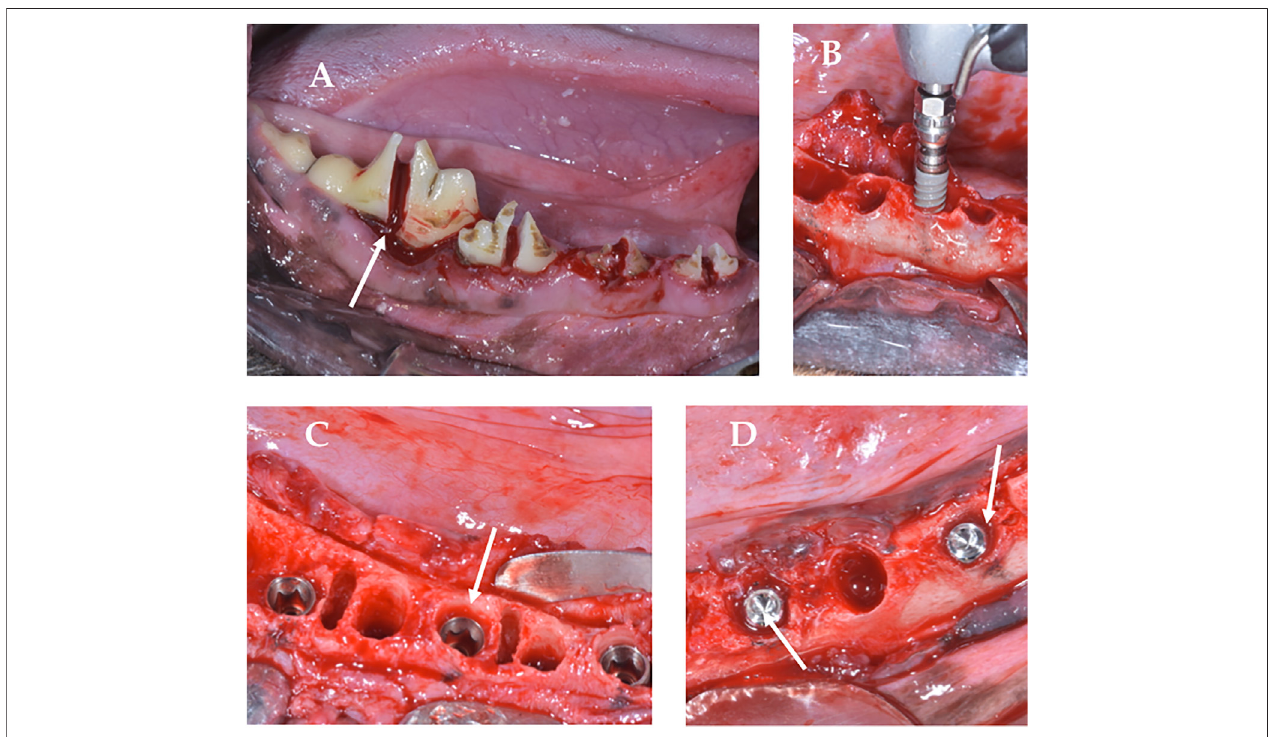
FIGURE 2 | Surgery. (A) , Odontosection; (B) , Implant insertion; (C) , Implant placed in subcrestal position with cover screws for submerged curing; (D) , Lack of friction between the implant and the bone